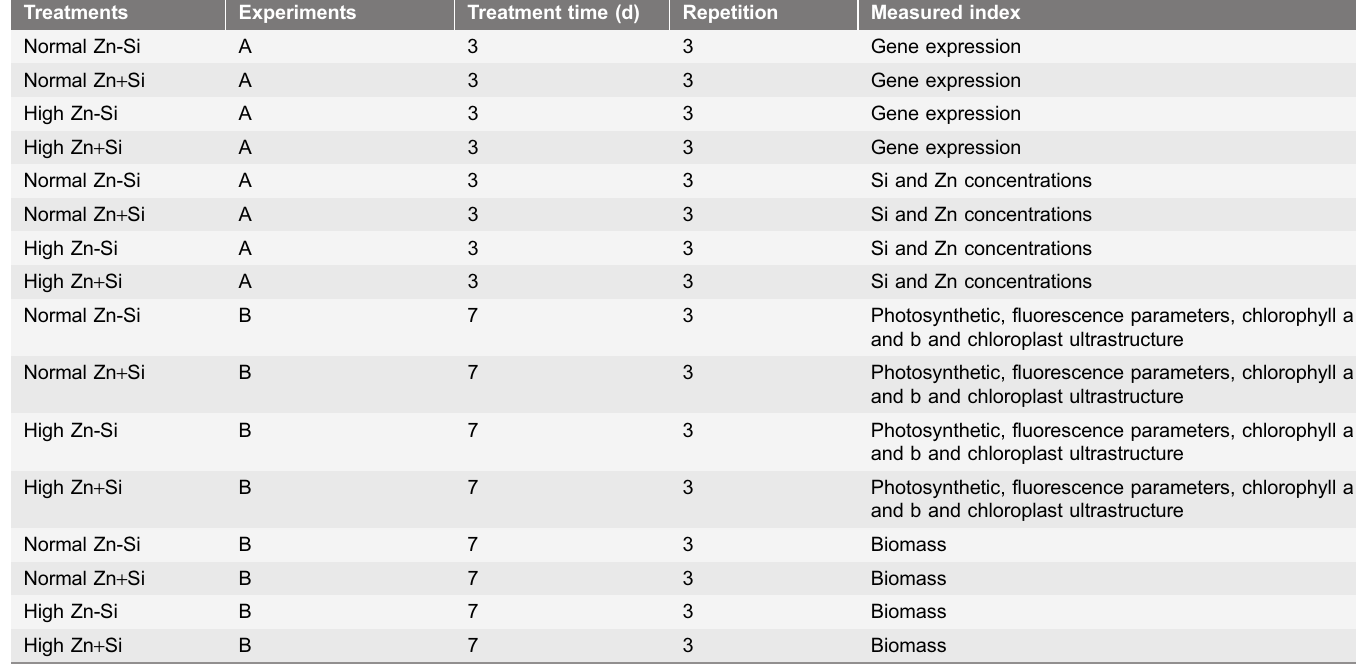
Table 1. Experimental design and measured